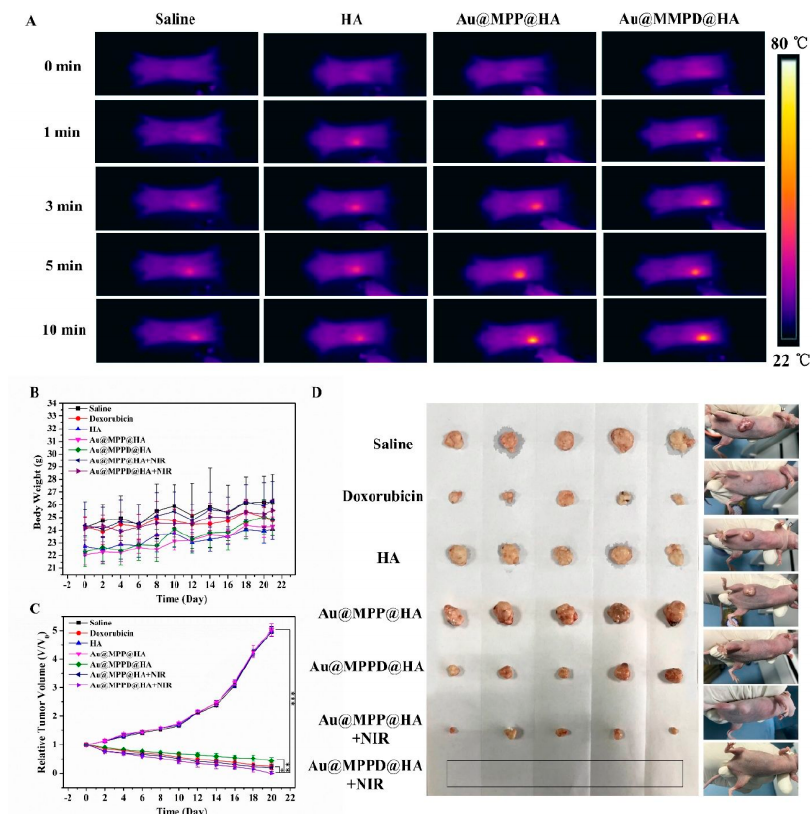
Figure 6. In vivo antitumor activities of nanocomposite hydrogels. ( A ) Thermographic photos of mice irradiated with near-infrared irradiation (NIR) laser irradiation at 0, 1, 3, 5, and 10 min (808 nm, 1 W/cm 2 ). ( B ) Body weight changes of experimental mice. ( C ) Relative tumor weight changes of mice. ( D ) Representative images of harvested tumors from corresponding mice after different treatments [121].